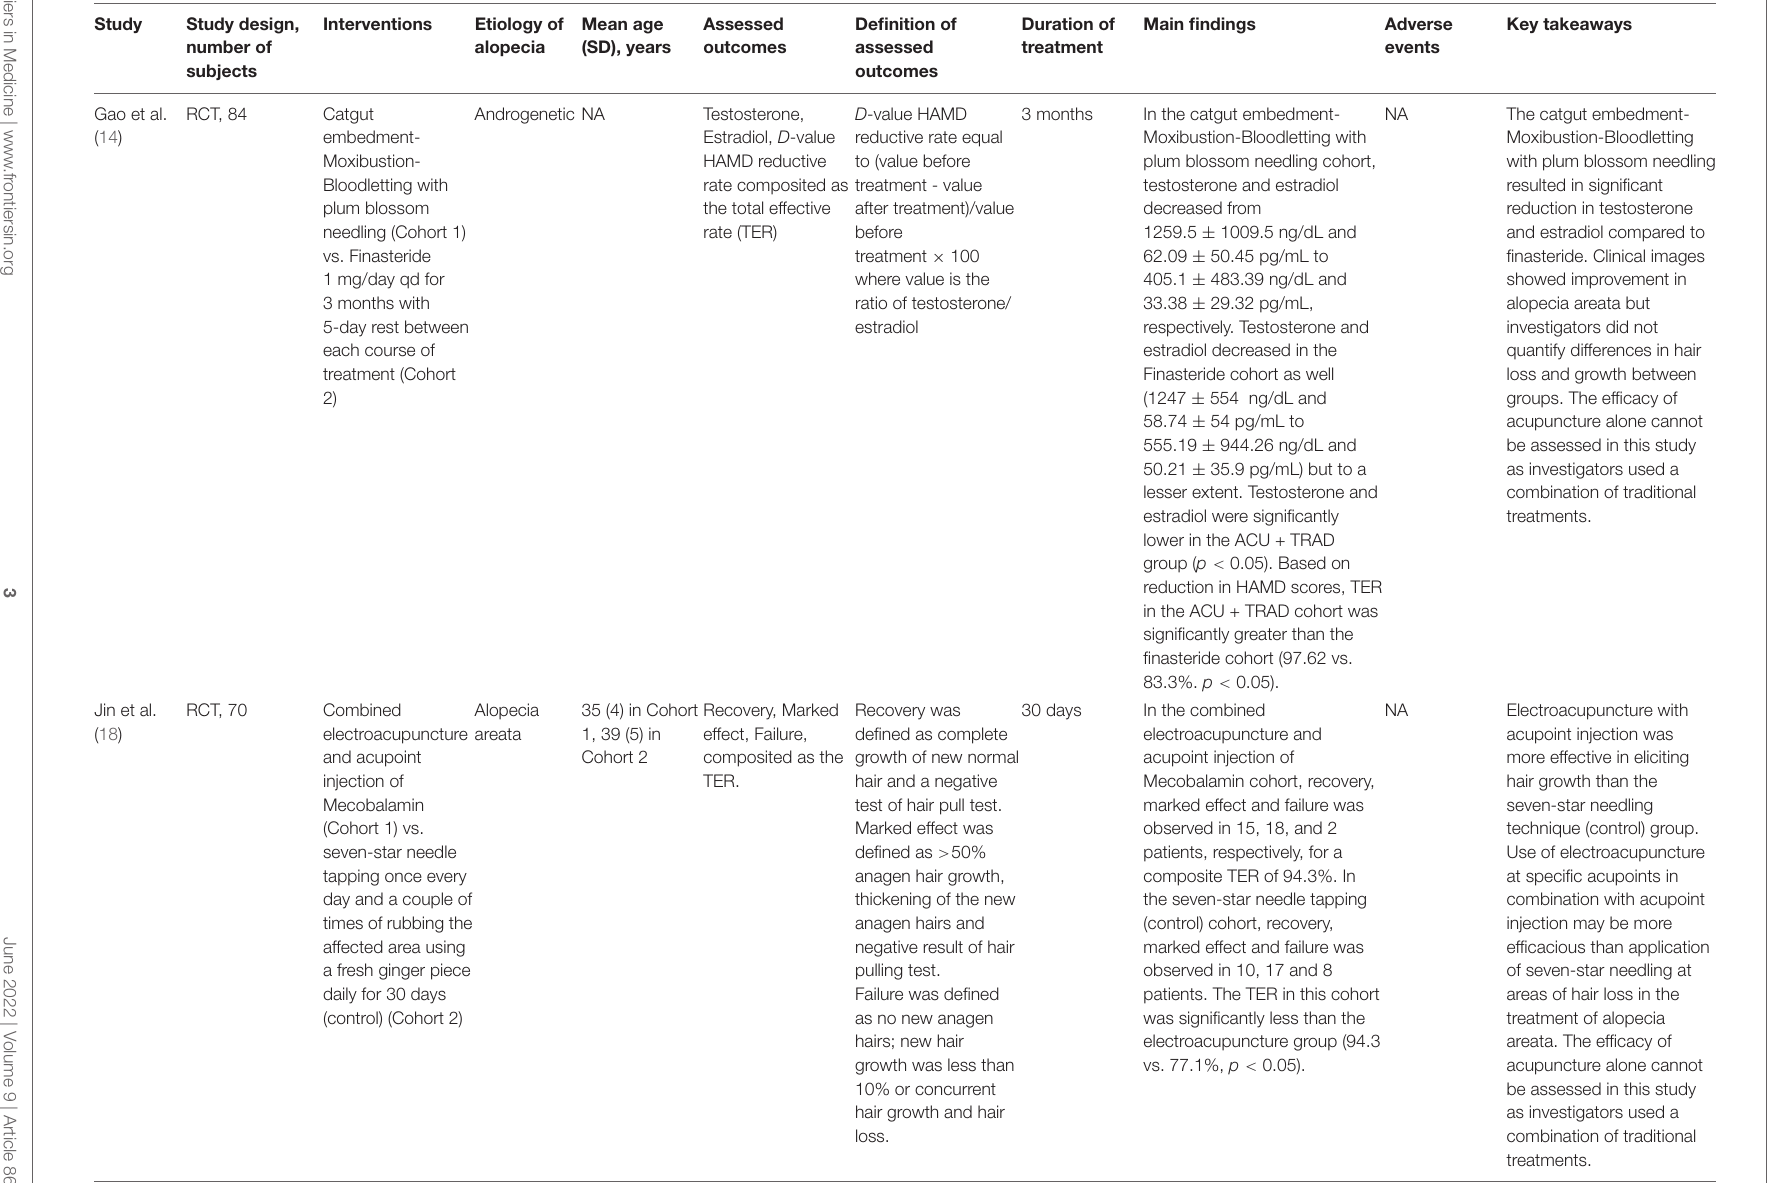
TABLE 1 | Efficacy of acupuncture and moxibustion for